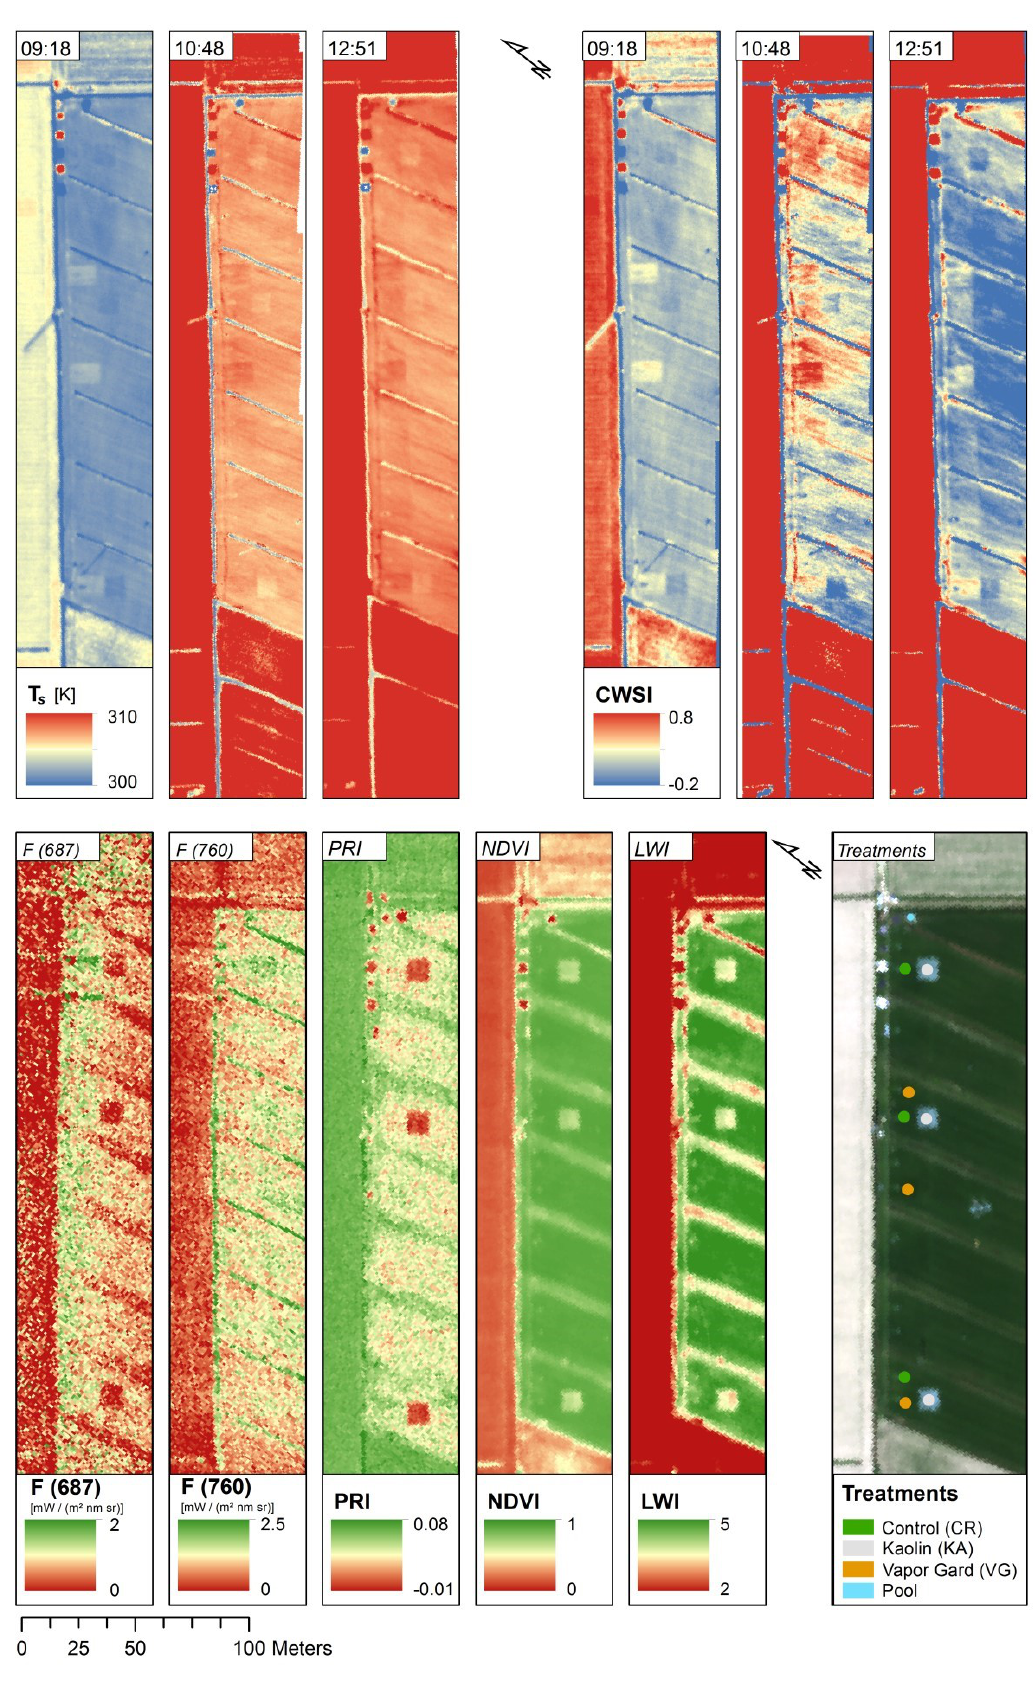
Figure 4. Diurnal T s [K] and CWSI maps at 11th June (top), F 687 , F 760 , PRI, NDVI and LWI maps of the same day (11th June, 14:52 CEST) (bottom left), and locations of the treatments (bottom